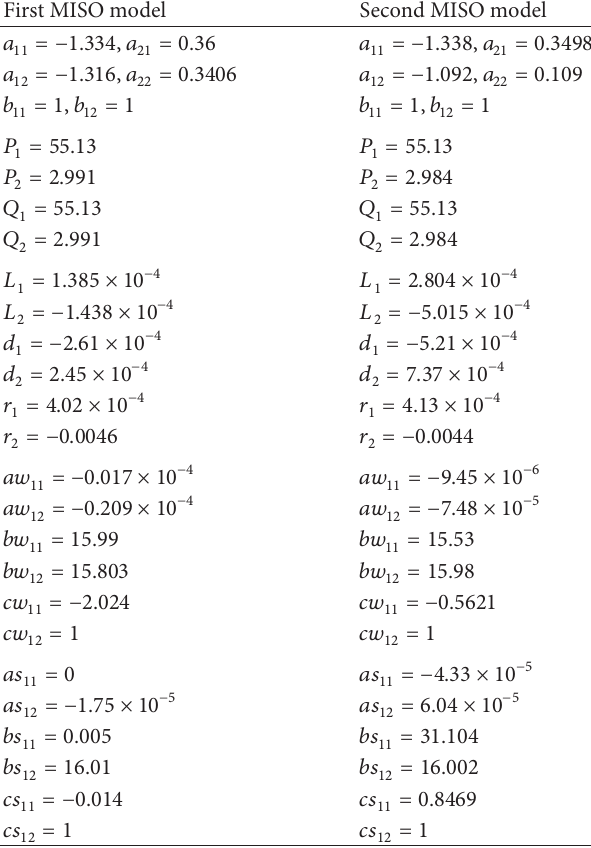
Table 3: Parameters of MISO Hammerstein models.